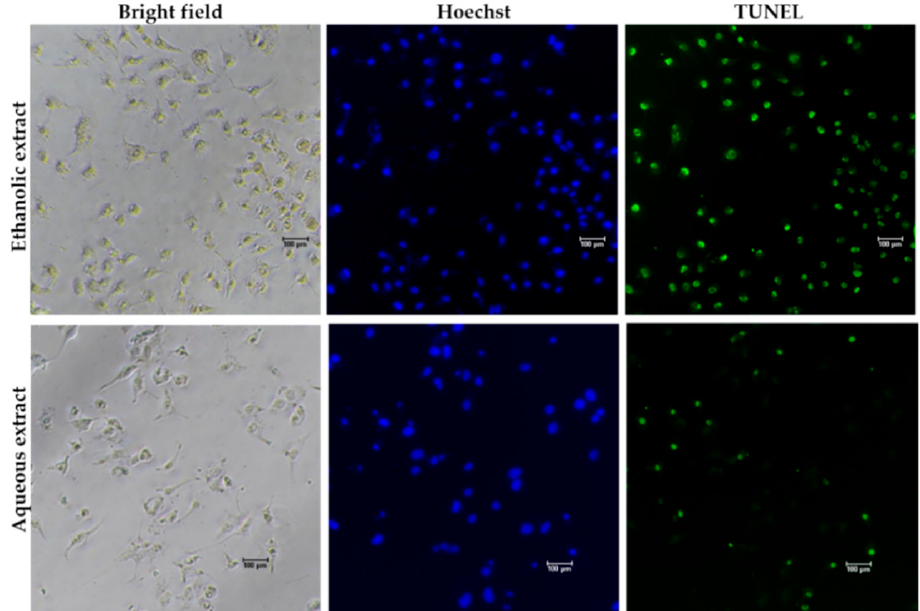
Figure 6. DNA fragmentation in treated Caco-2 cells after 48 h of treatment with 250 µg/mL of red jasmine rice ethanolic extract and 3000 µg/mL of red jasmine rice aqueous extract after investigation by TUNEL assay and fluorescent microscope.